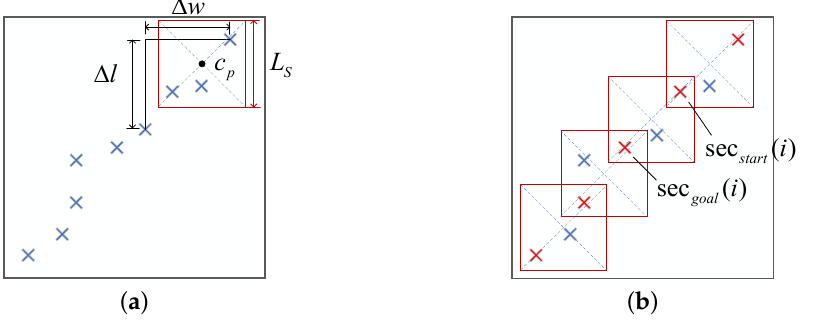
Figure 7. Map segmentation and parallel computing. ( a ) Map segmentation. ( b ) Parallel